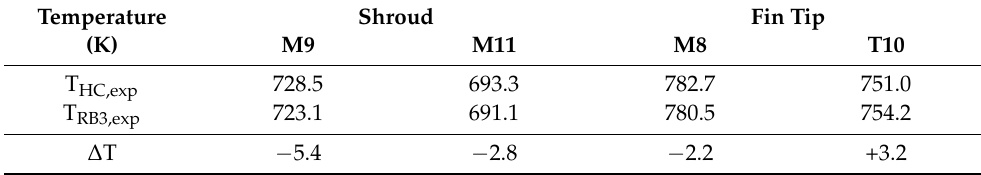
Table 12. Temperature in the labyrinth seal region for test 3 and test 3 bis.